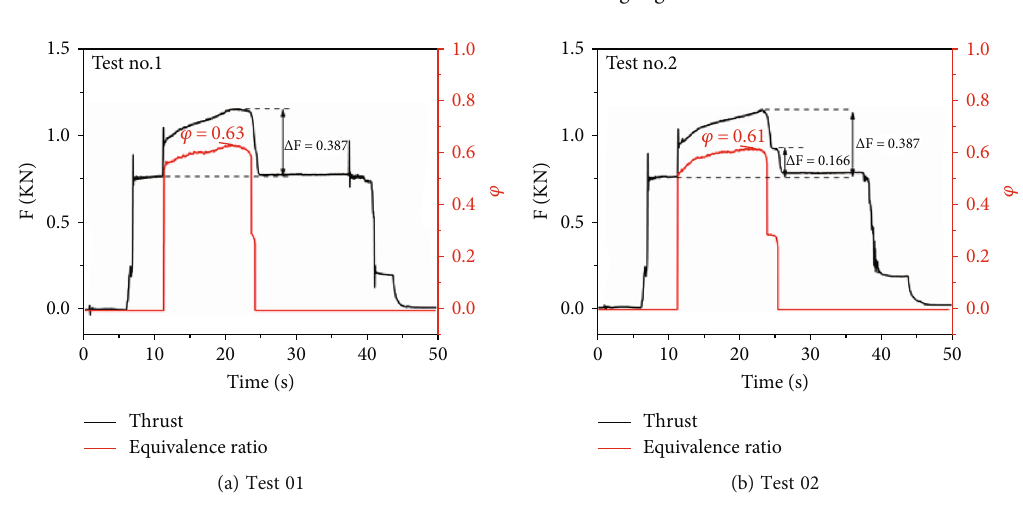
Figure 8: Evolution of the thrust and equivalence